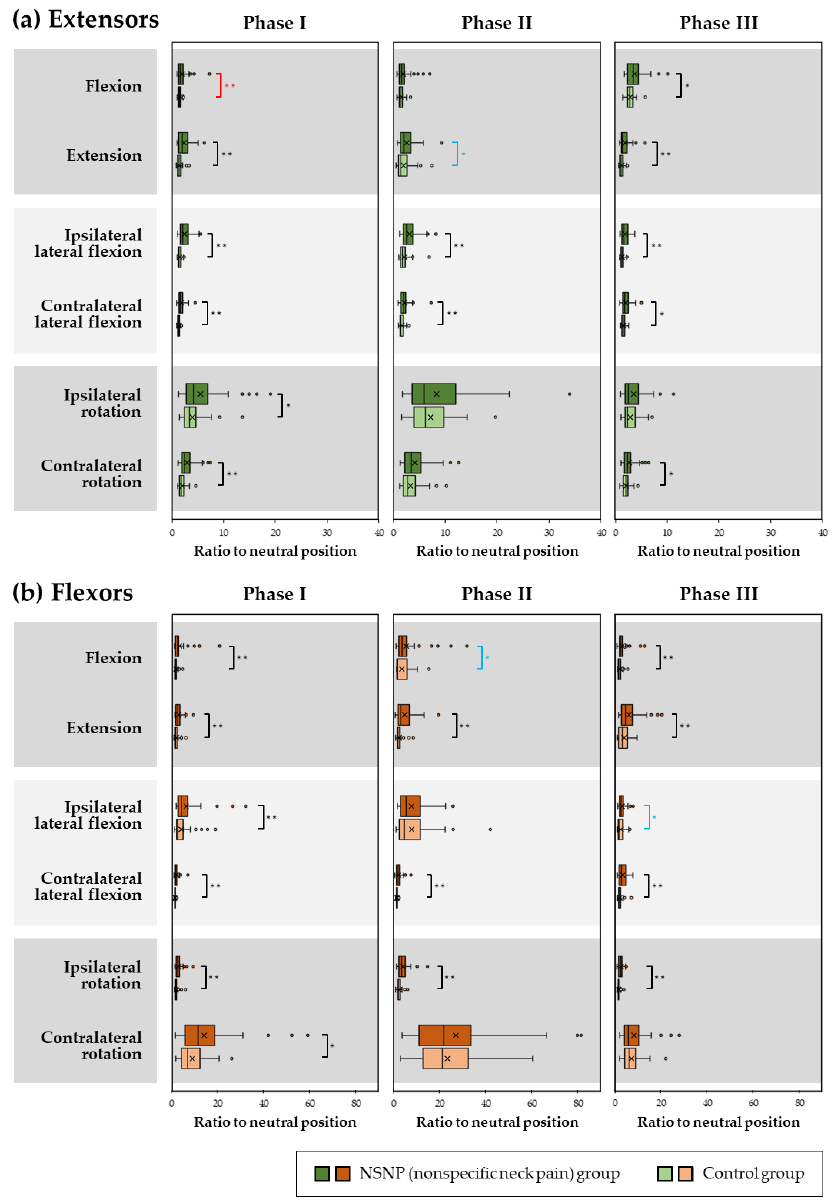
Figure 2. Ratio of muscle activity in the motions to the neutral position in each phase for the cervical ( a ) extensors and ( b ) flexors in the NSNP and control groups. For the extensors, the ratios in all phases in flexion, Phase I in extension, Phase I in contralateral lateral flexion, Phase II in ipsilateral rotation and Phase III in contralateral rotation in the control group, and Phase III in flexion in the NSNP group were normally distributed but not for the remaining phases. For the flexors, the ratios in Phase II in contralateral rotation in the control group, and Phase III in ipsilateral rotation in the NSNP group were normally distributed but not for the remaining phases. Red asterisks indicate a significant difference in only parametric analysis, blue asterisks indicate a significant difference in only nonparametric analysis, and black asterisks indicate a significant difference in both analyses. The top, middle, and bottom lines of the boxes correspond to the 75th, median, and 25th percentile, respectively. The whiskers extend from the minimum to maximum. The cross marks indicate the arithmetic means. The powers were less than 0.8 in 15 phases (extensors: flexion, extension, and contralateral rotation in Phase II; ipsilateral rotation in phase I, II, and III; flexors: flexion, extension, and contralateral rotation in Phase II and III; ipsilateral lateral flexion in phase I, II, and III). The rest of the 21 phases were β ≥ 0.8. * indicates, p < 0.05 and ** indicates p <